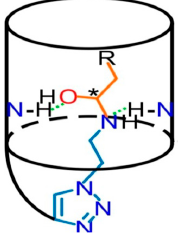
Figure 9. Stabilization of labile imine and hemiaminal intermediates through hydrogen bonding and hydrophobic effects by an endo-functionalized cavitin (Li et al., 2022)